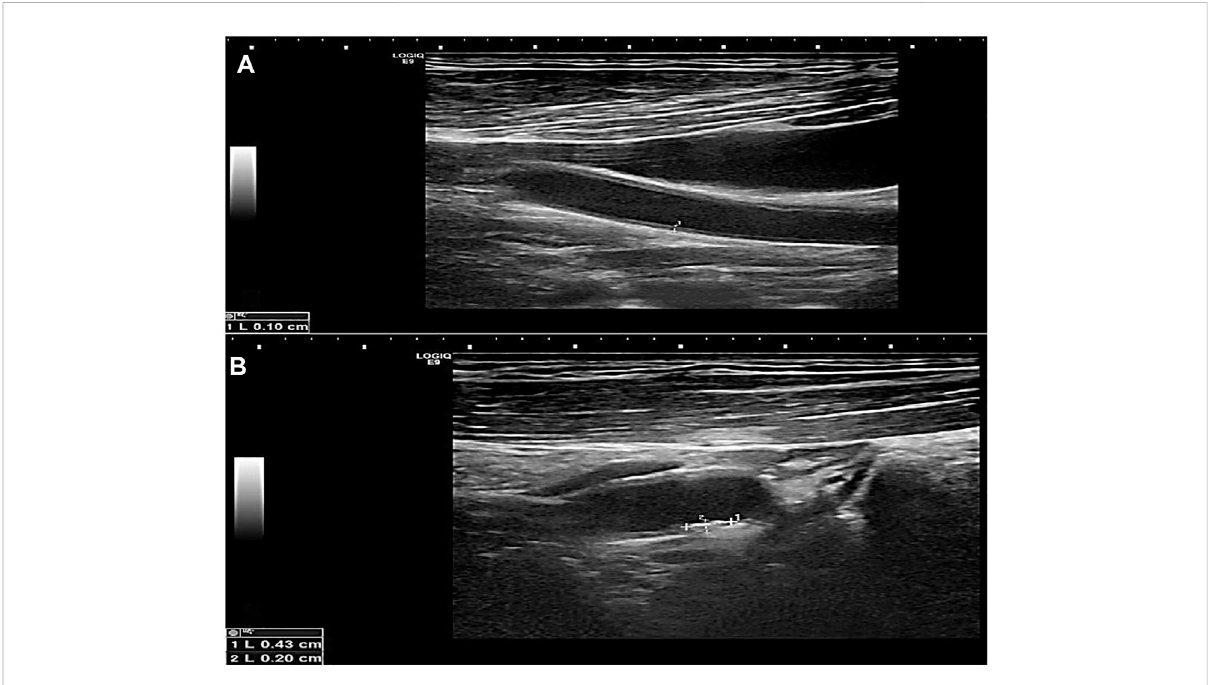
FIGURE 2 Greyscale longitudinal ultrasound images in a 60-year-old male diabetic patient showing (A) increased intimal/medial thickness at the left common carotid artery and (B) a calci fi ed plaque at the proximal aspect of the left internal carotid